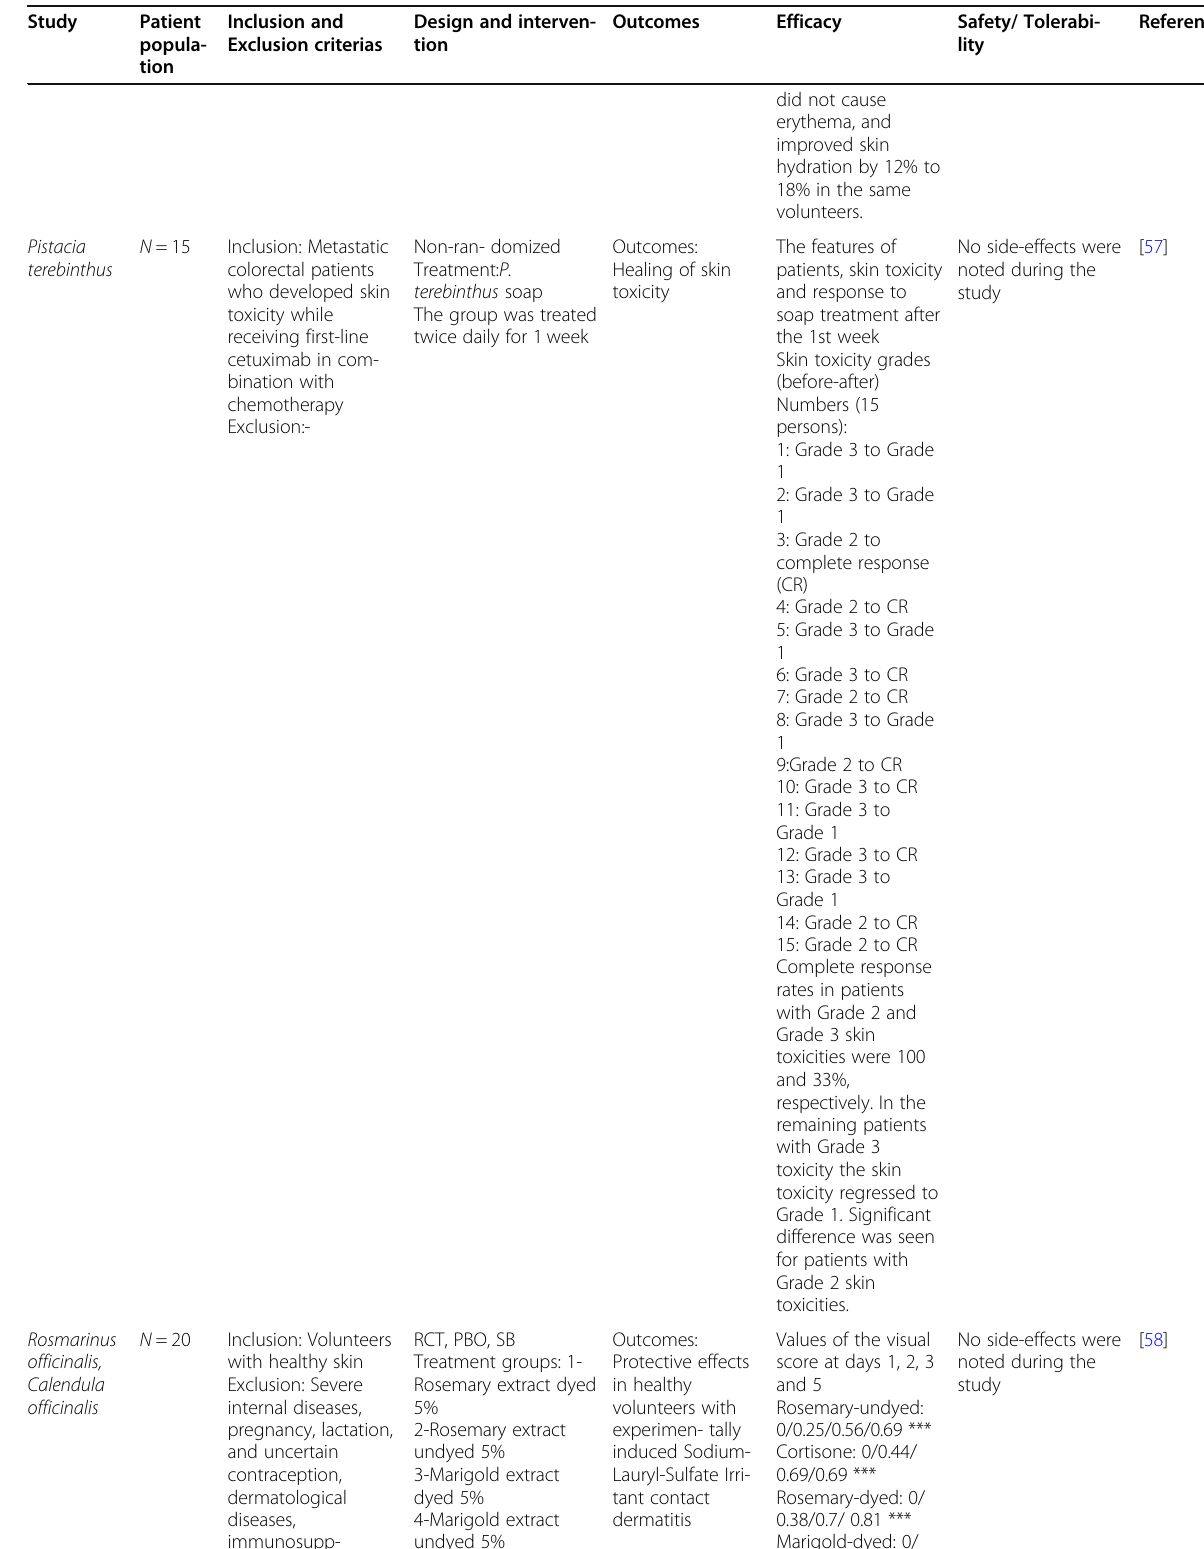
Table 4 Clinical trials of the traditional plants used for skin problems in Turkey (Continued) Study Patient